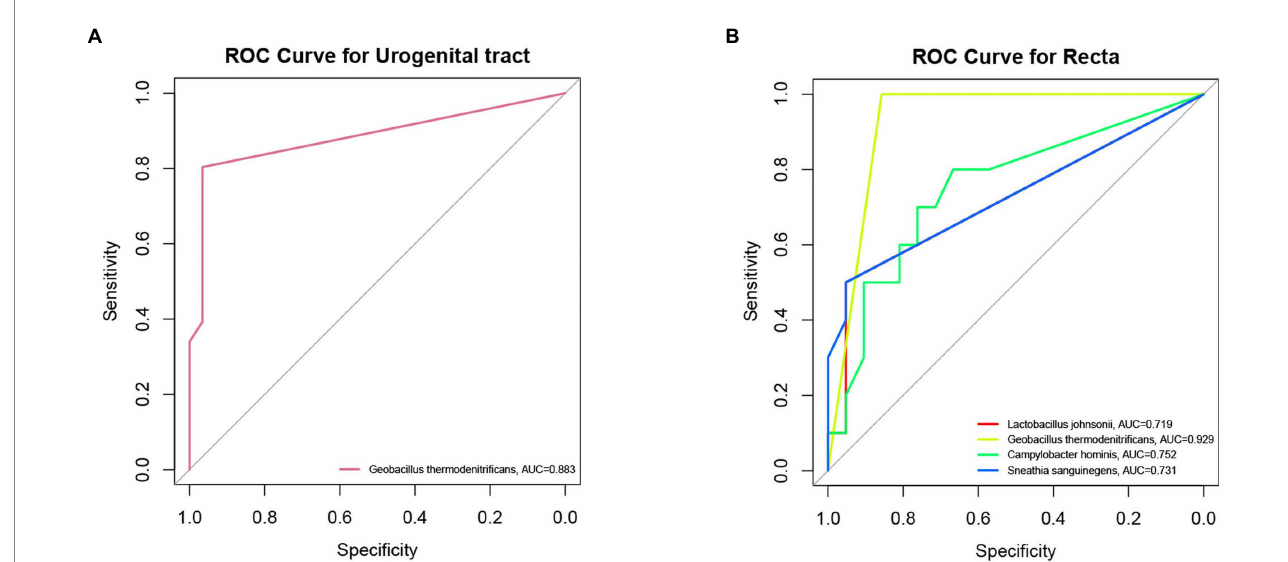
FIGURE 5 ROC analysis predicted major biomarkers that could distinguish infertile patients from controls. (A) Discrimination of Geobacillus thermodenitrificans in the urogenital tract (cervix, vagina, intestine), AUC = 0.883. (B) The discriminative effect of different rectal biomarkers ( Geobacillus thermodenitrificans ,